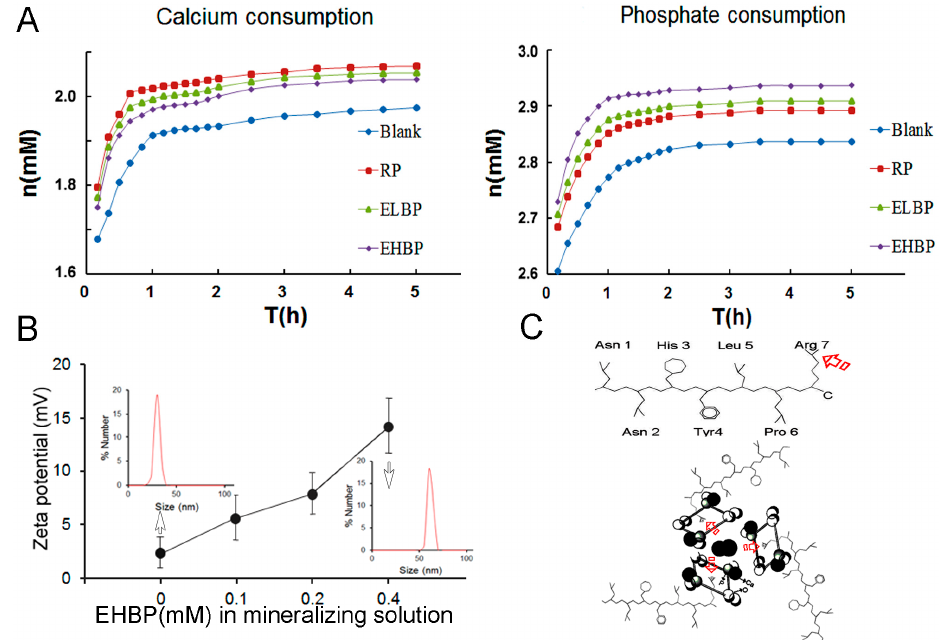
Figure 5. Rate of calcium (( A ) left) and phosphate (( A ) right) consumption in the presence of: no peptide, 0.4 mM RP, 0.4 mM ELBP and 0.4 mM EHBP. Zeta potentials of solution particles after EHBP added at different concentrations from 0 to 0.4 mM ( B ) and the change of particle distributions without EHBP (( B ), inset) and in presence of 0.4 mM EHBP (( B ), inset). The amino group arrangement of EHBP (( C ) upper) and the interaction between EHBP and calcium phosphate clusters was schematically illustrated, where the arrow indicates the possible binding sites of EHBP to the PO4 3 − group (( C ), lower).